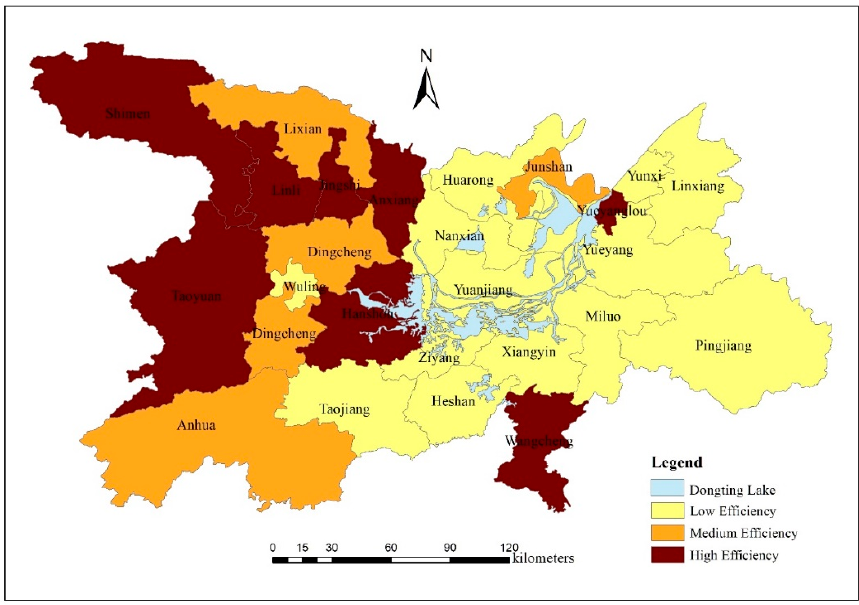
Figure 2. Spatial distribution of cultivated land use efficiency environmental constraints in 2017.